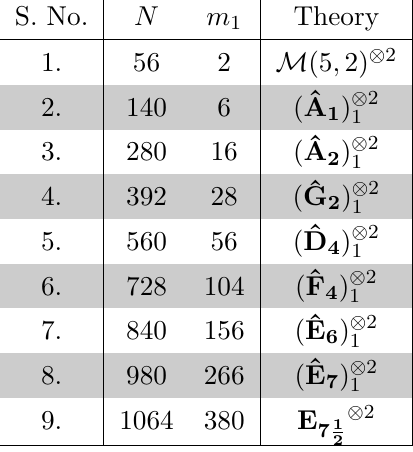
Table 6 . Category I :